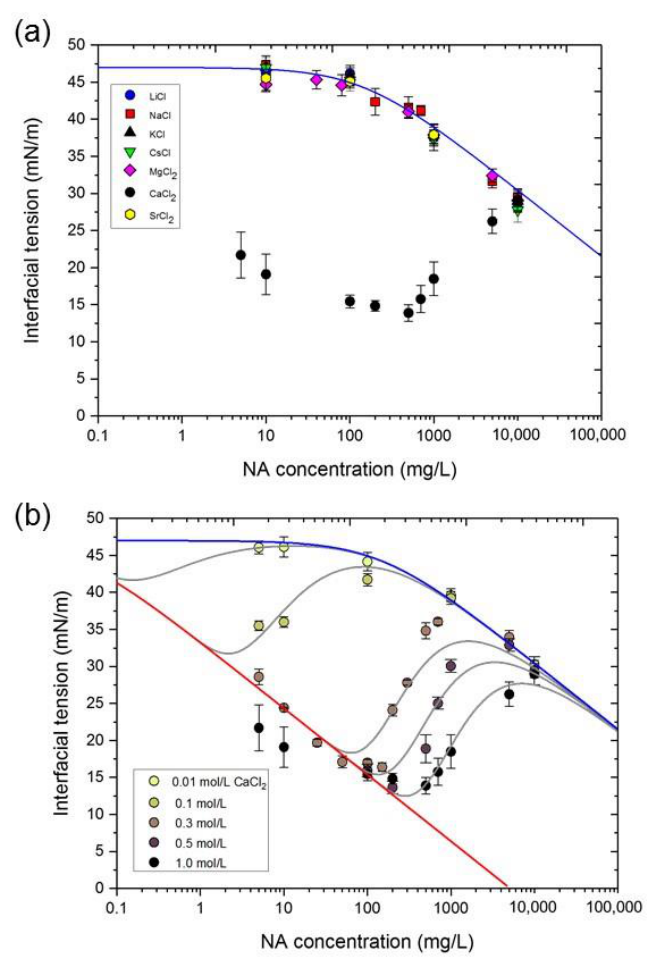
Figure 3. ( a ) Interfacial tension-log (naphthenic acid concentration) profiles at the n -heptane/water interface in the presence of the indicated cations (all chloride salts at 1 mol/L). ( b ) Corresponding profiles for different aqueous Ca 2+ concentrations. The blue and red curves represent the respective limiting conditions for deionized water and a “Ca 2+ -saturated” interface, and the gray curves are derived from Equation (13).